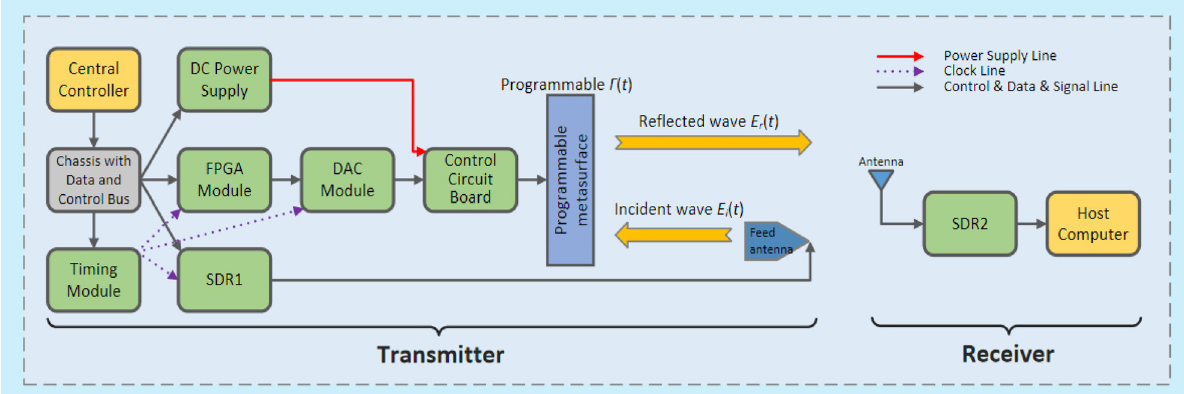
Figure 3: The hardware architecture of the programmable metasurface-based wireless communication system [70]. Reprinted from [70], with the permission of IEEE Publishing.